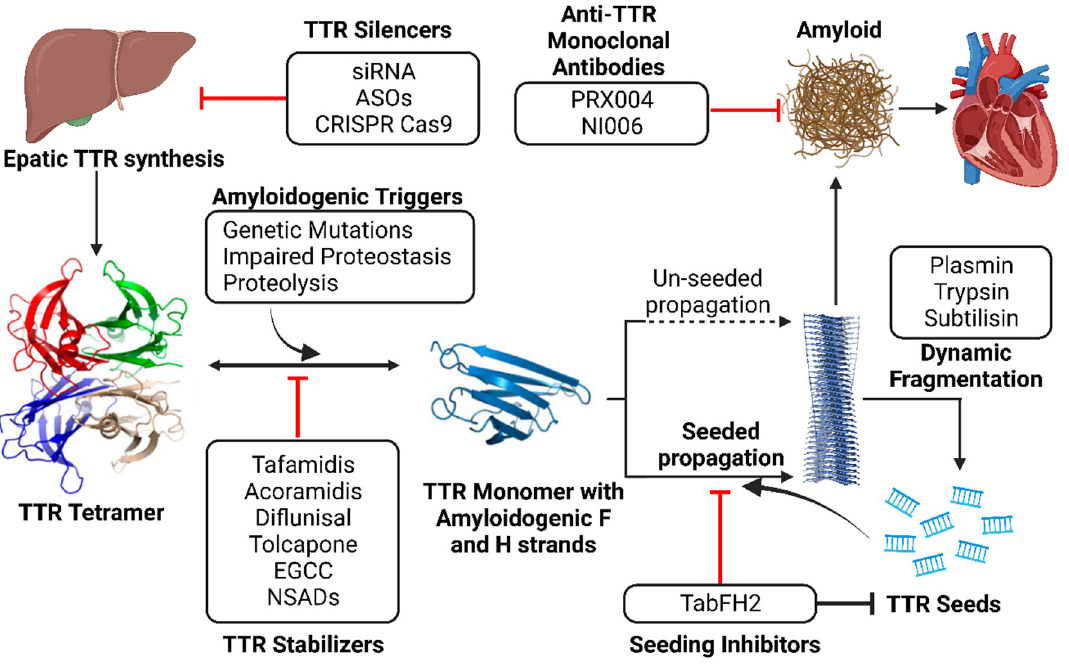
Figure 5. Multi-target approach to ATTR amyloidosis. TTR dissociation provides monomers with high propensity to nucleation and fibril formation through self-association of amyloid-driving seg- ments. TTR stabilizers maintain the tetrameric form, halting tetramer dissociation and unseeded polymerization. After spontaneous and proteolytic fragmentation of fibrils, small fragments may serve as seeds that induce amyloid seeded propagation. The peptide inhibitor TabFH2 does not affect tetramer stability, but it binds to seeds, hindering self-recognition and seeding. Both strategies seem synergistic and could potentially be used in combination. The contemporary administration of TTR silencers and anti-TTR monoclonal antibodies may prove effective since they block TTR synthesis and promote amyloid regression.